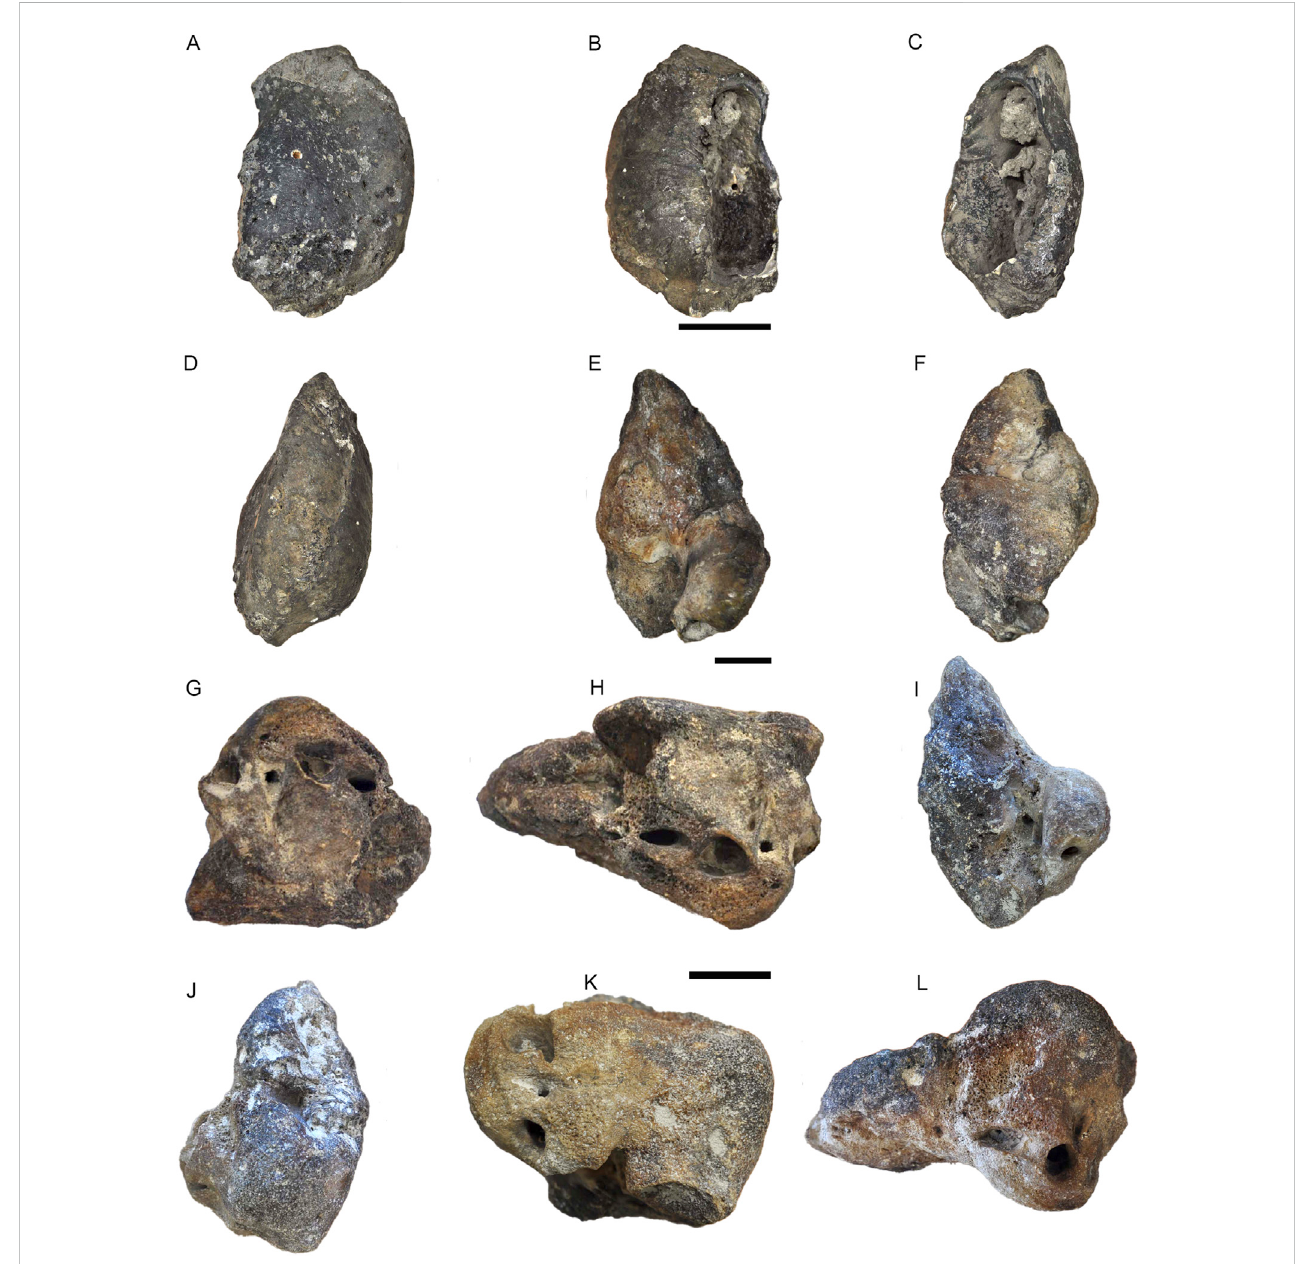
FIGURE 9 Eubalaena sp.SAM-PQ-3096in (A) ventral, (B) dorsal, (C) lateral,and (D) medial view,scale=5 cm.Mysticetiindet., SAM-PQ-3091 in (E) ventromedial, (F) lateral, (G) posterior, and (H) dorsal view, scale=2 cm. SAM_PQ-3080 in (I) ventromedial, (J) lateral, (K) posterior, and (L) dorsal view, scale=2